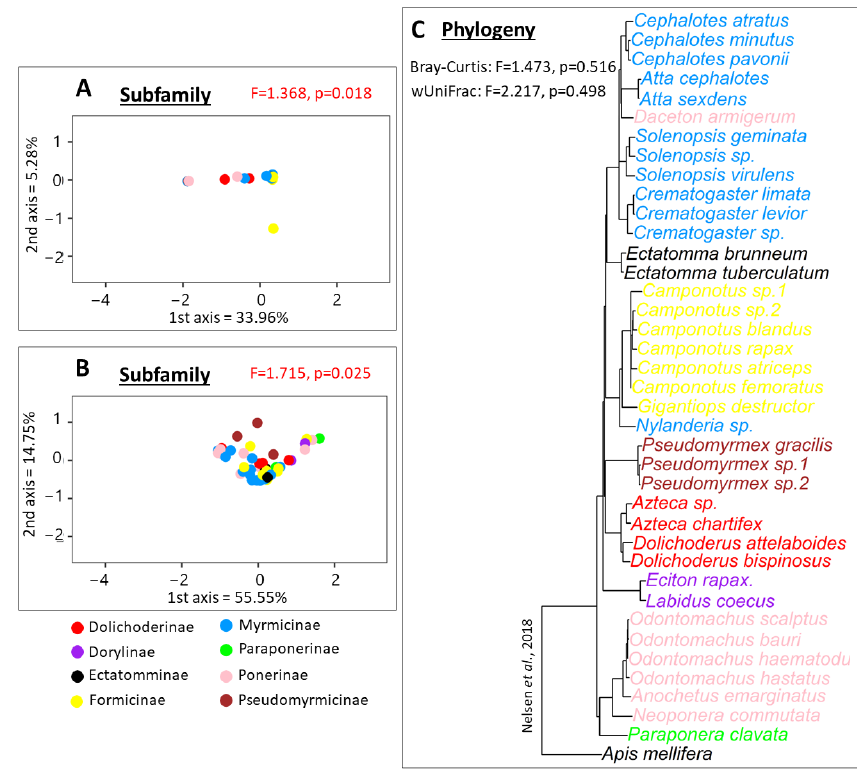
Figure 3. Differences in bacterial communities visualized with PCoAs across ant subfamily ( A , B ) and phylogeny ( C ). The distances used were the Bray–Curtis ( A , C ) and wUniFrac ( B , C ). The statistical p -values were obtained with pairwise PERMANOVAs.